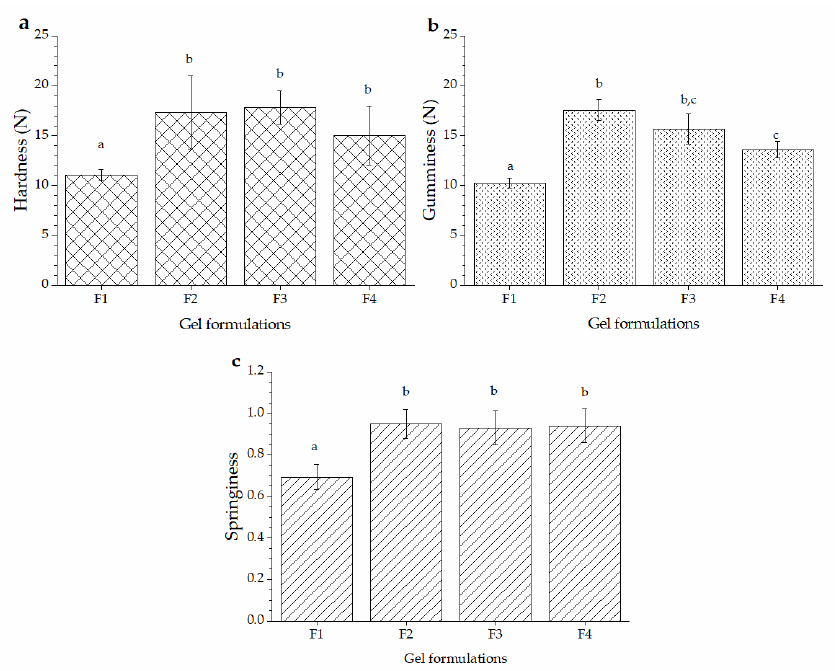
Figure 3. TPA analysis of gel formulations: ( a ) Hardness, ( b ) gumminess, and ( c ) springiness of the F1 (control formulation), F2 (100% agave syrup), F3 (100% agave fructan), and F4 (50% agave syrup